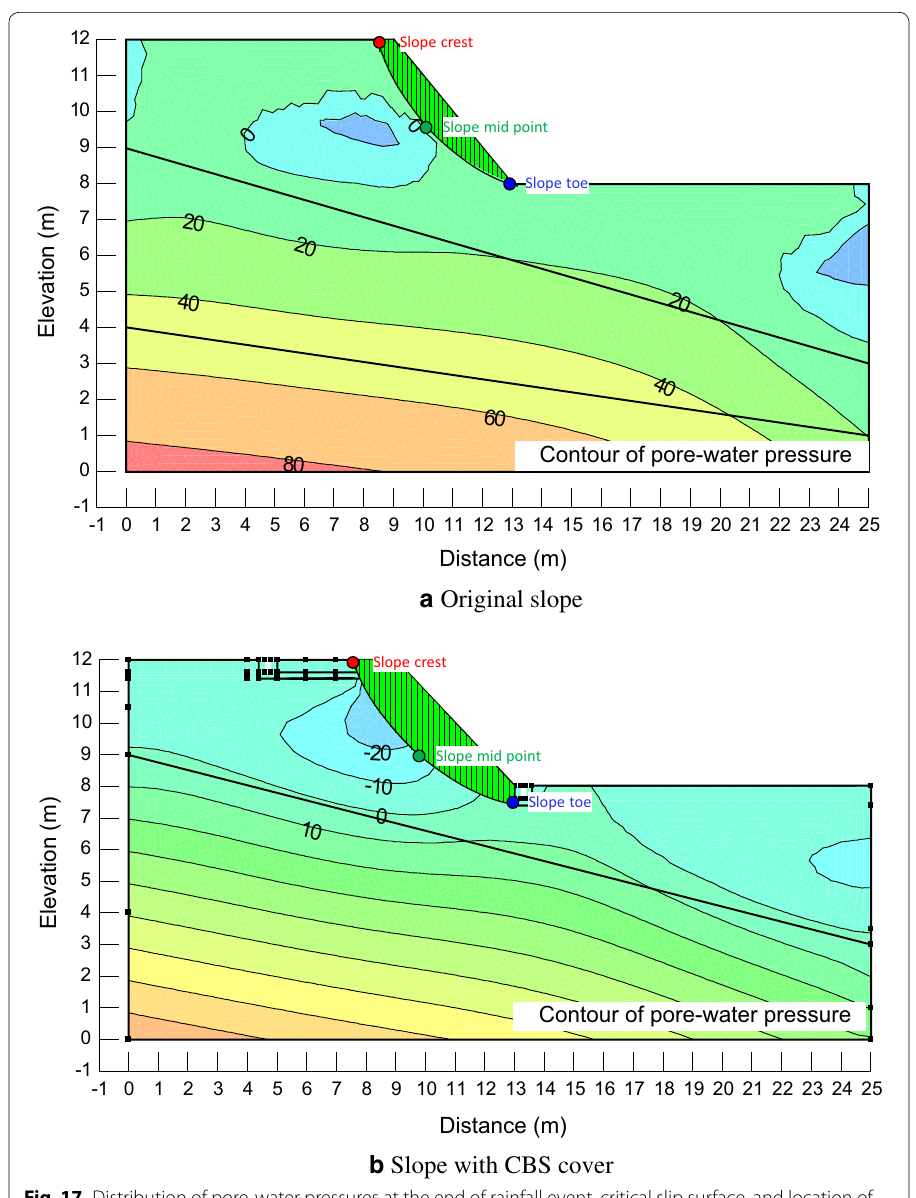
Fig. 17 Distribution of pore-water pressures at the end of rainfall event, critical slip surface, and location of the observed deformations on the